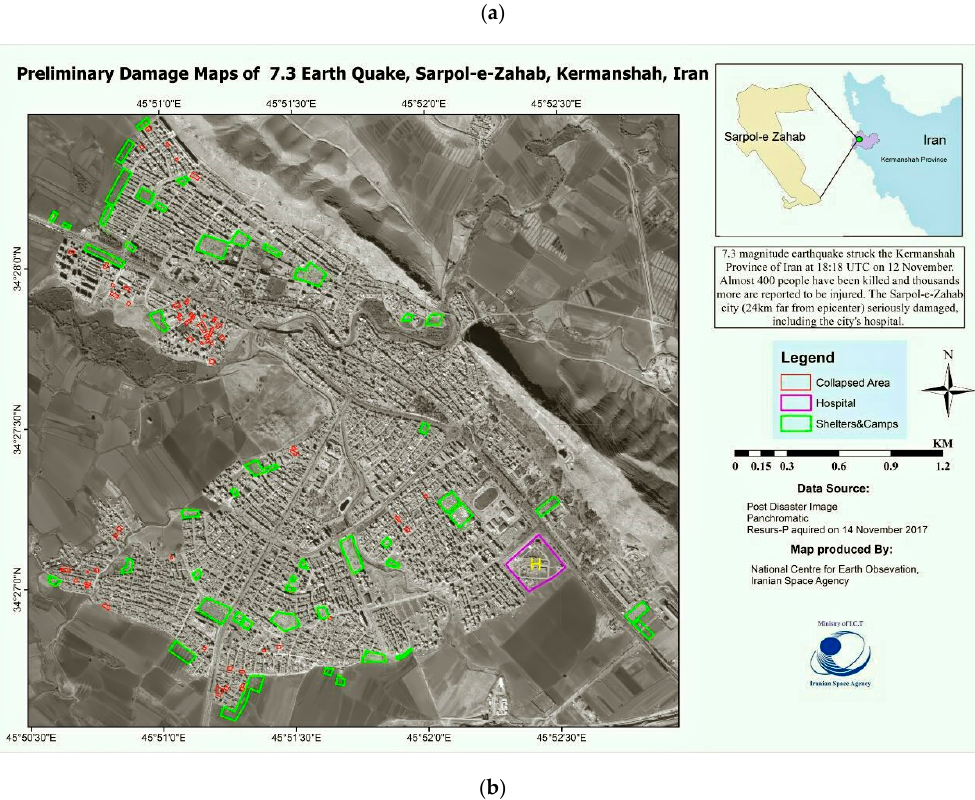
Figure 3. The primary result was reported by ( a ) UNITAR-UNOSAT and ( b ) the Iranian Space Agency.